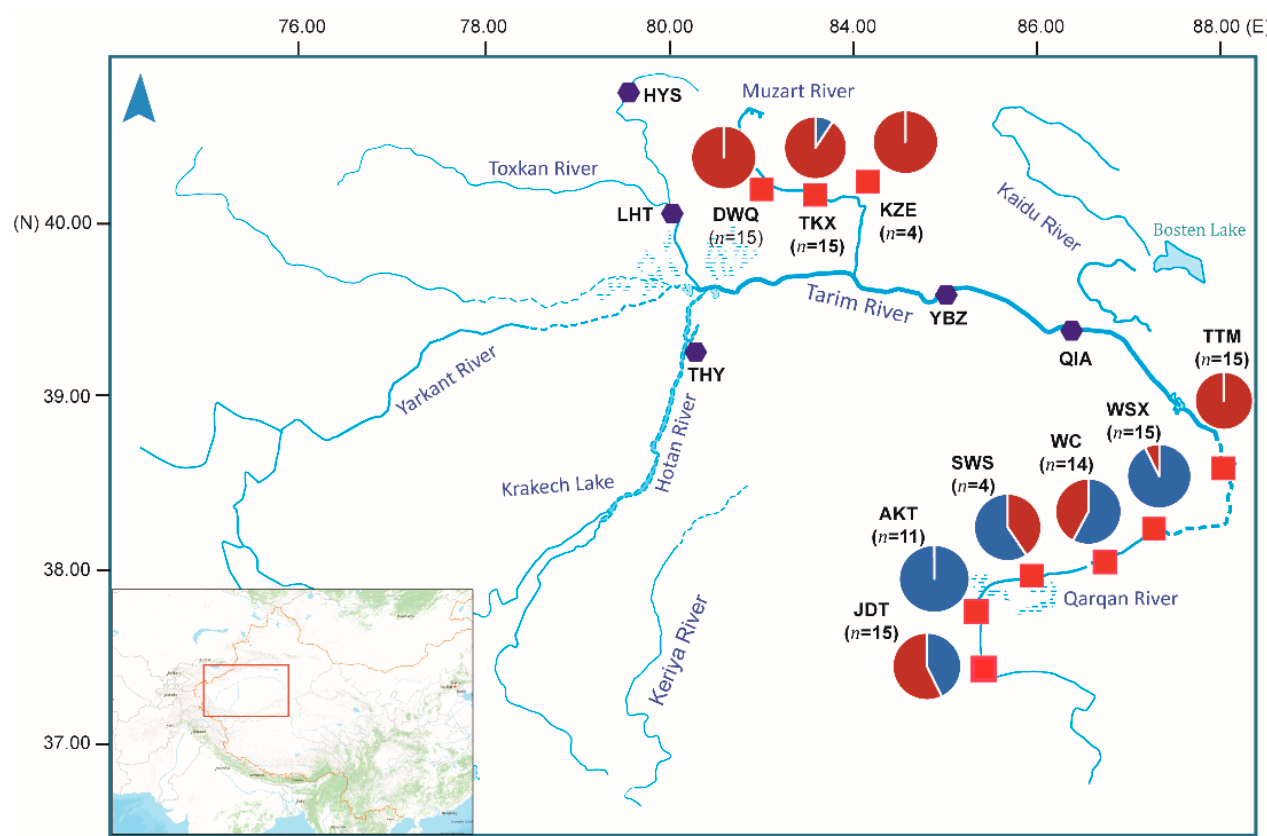
Figure 1. Sample sites of T. yarkandensis in the Tarim River basin located in Xinjiang. The hexagon symbol colored in dark purple represents the sampling locations where no specimen was collected. The red square symbols indicate the sampling locations used in this study. The pie in the map represents average admixture proportion of two genetically distinct clusters estimated with